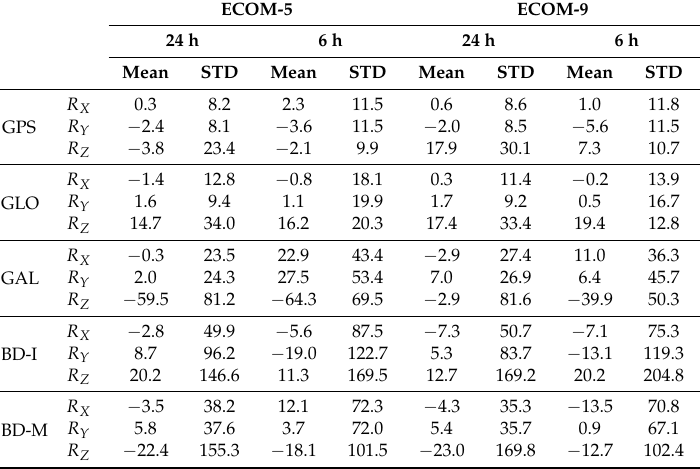
Table 4. The effects of Helmert rotational parameters on orbits at the nominal altitude of each navigation systems in the selected fitted arc length intervals (GPS: 40–45 h; GLONASS: 36–45 h; Galileo: 42–48 h; BeiDou inclined geo-synchronous orbit (IGSO): 42–48 h; BeiDou medium earth orbit (MEO): 39–54 h; BD-I/M represent BeiDou-IGSO/MEO, respectively; unit: mm).